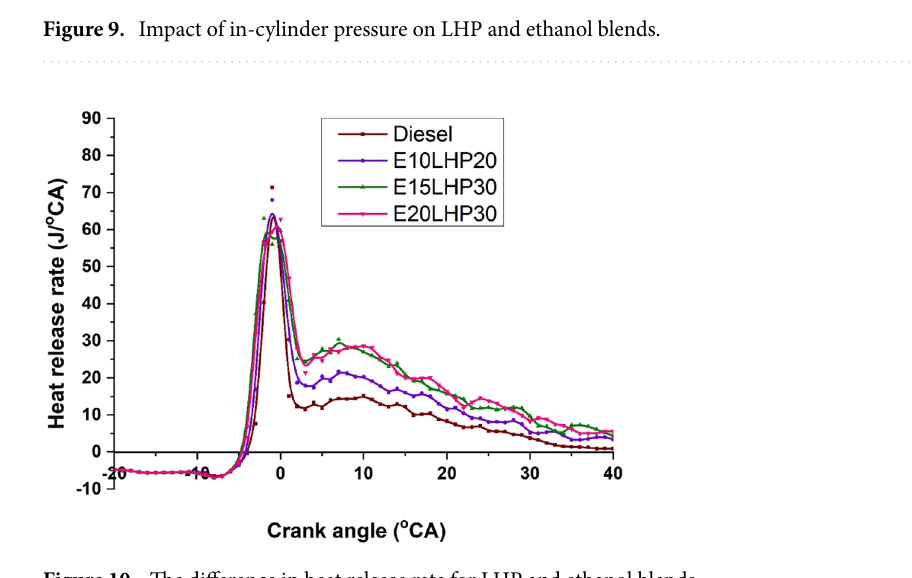
Figure 10. The difference in heat release rate for LHP and ethanol